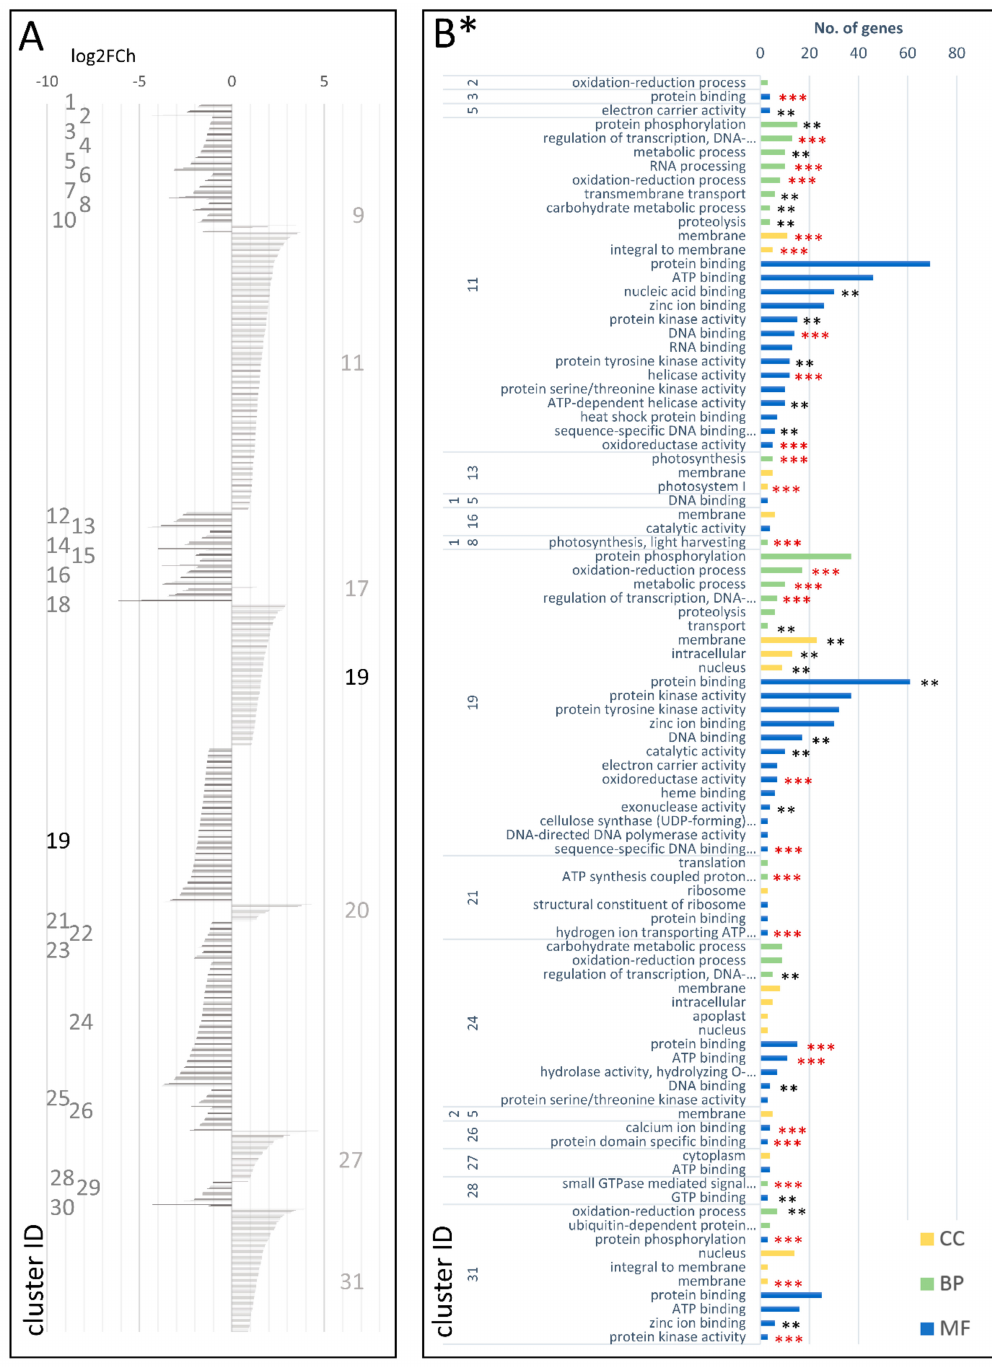
Figure 4. Clusters of DEGs in the cultivated carrot (young plant vs. developing root; cDEG.1.2) showing log2FoldChange values ( A ) and GO enrichment results ( B ). CC—cellular component; BP—biological process MF—molecular function; *—number of genes in set >2; **—adjusted p -value < 0.01; and ***—adjusted p -value <